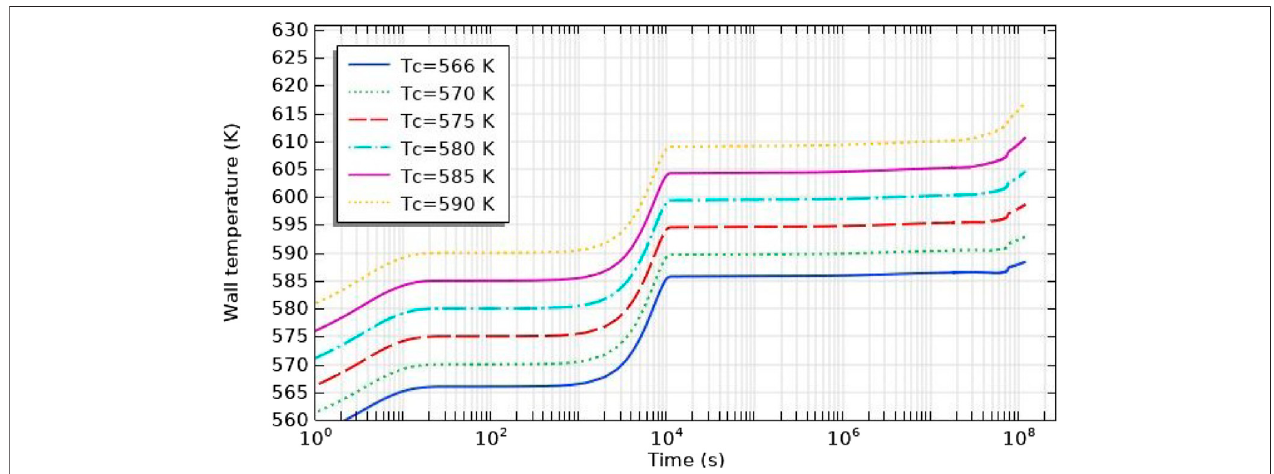
FIGURE 3 | Evolution of wall temperature under 15.5 MPa with different coolant temperatures and G (cid:1) 16500 kg/s.